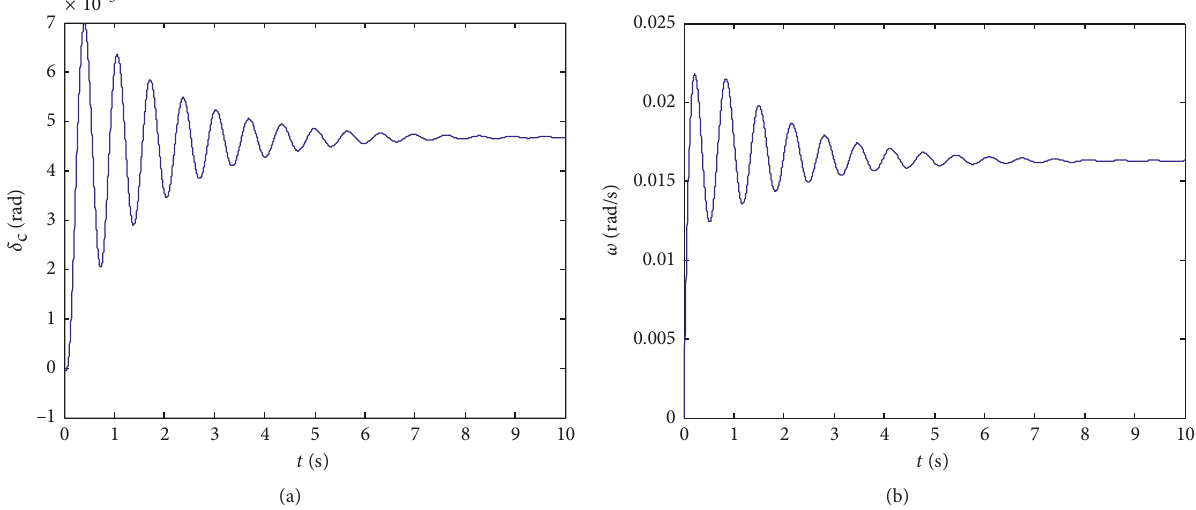
Figure 4: Time history of (a) compliance steering angle and (b) yaw rate, for the case of u